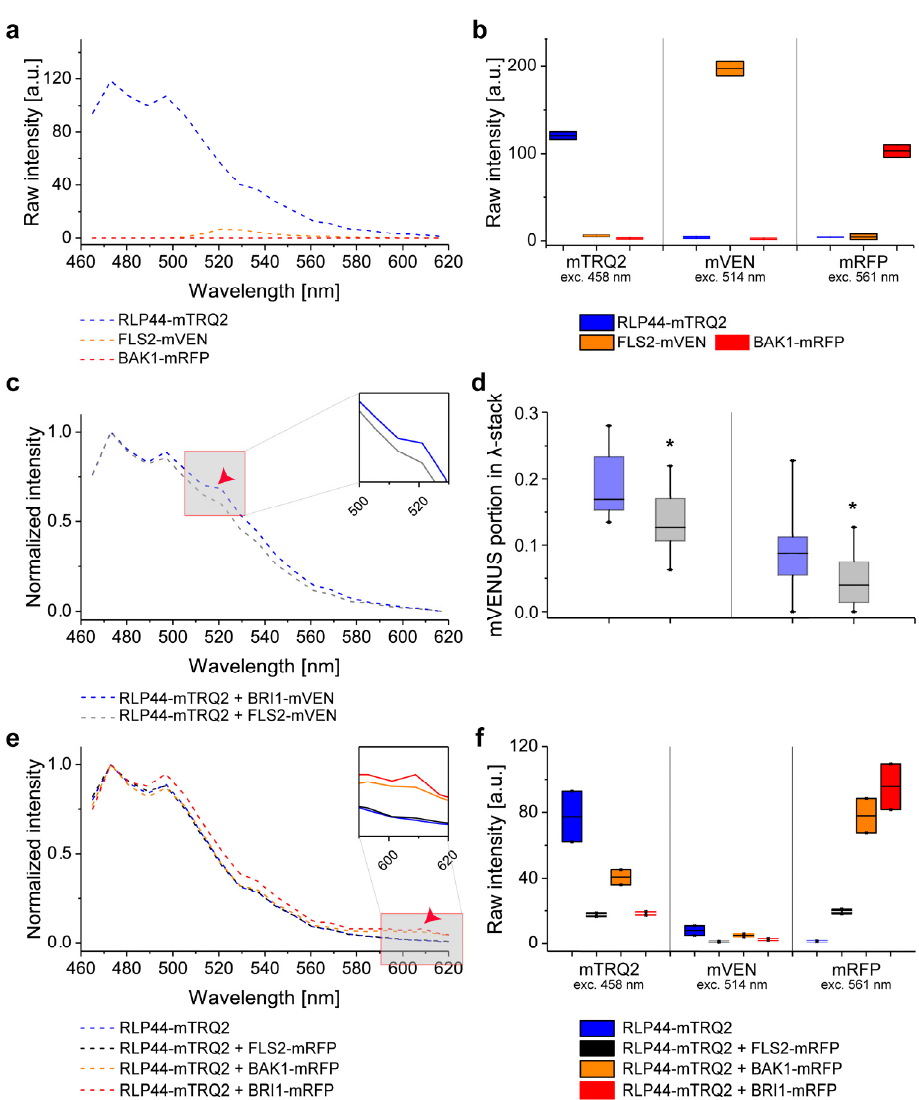
Figure 3. Interaction of RLP44 with BAK1 and BRI1 is detectable in the plasma membrane of N. benthamiana epidermal leaf cells by intensity-based spectral FRET. ( a ) Wavelength-dependent intensity of fluorescence emission after irradiation of the cells with 458 nm light for RLP44-mTRQ2 (blue), FLS2-mVEN (orange) and BAK1-mRFP (red). ( b ) Emission intensity after irradiation with light of different wavelengths in the mTRQ2 (left, 458 nm), mVEN (middle, 514 nm) and mRFP channels (right, 561 nm) from 8-bit images for RLP44-mTRQ2 (blue), FLS2-mVEN (orange) and BAK1-mRFP (red) after correction for spectral bleed-through. ( c ) Wavelength-dependent normalized fluorescence emission for RLP44-mTRQ2 co-expressed with BRI1-mVEN (blue) or with FLS2-mVEN (grey). For both spectra, the average donor-to-acceptor ratio was around 1:4 (0.26). The FRET-relevant wavelength area is as an inset and the occurrence of FRET from RLP44-mTRQ2 to BRI1-mVEN is indicated by a red arrow head. The data are presented as the mean (n ≥ 13). ( d ) Protein-dependent, relative mVEN emission signal after irradiation of the cells with light of 458 nm light. Fusion protein ratios of about 1:4 (left) and 1:10 (right) of the RLP44-mTRQ2/BRI1-mVEN pair (blue) and RLP44-TRQ2/FLS2-mVEN pair (grey) are shown. Significant changes [ n = 7 (left), n = 12 (right)] in a two-sided 2-sample t -test with p < 0.05 are indicated by asterisks. ( e ) Wavelength-dependent normalized fluorescence emission after irradiation of the cells with 458 nm light for RLP44-mTRQ2 alone (blue), RLP44-mTRQ/FLS2-mRFP (black), RLP44-mTRQ/BAK1-mRFP (orange) and RLP44-mTRQ/BRI1-mRFP (red). The FRET-relevant wavelength area is highlighted in an enlarged section and the occurrence of FRET fromRLP44-mTRQ2 to BAK1-mRFP or BRI1-mRFP is indicated by a red arrow head. ( f ) Emission intensity after